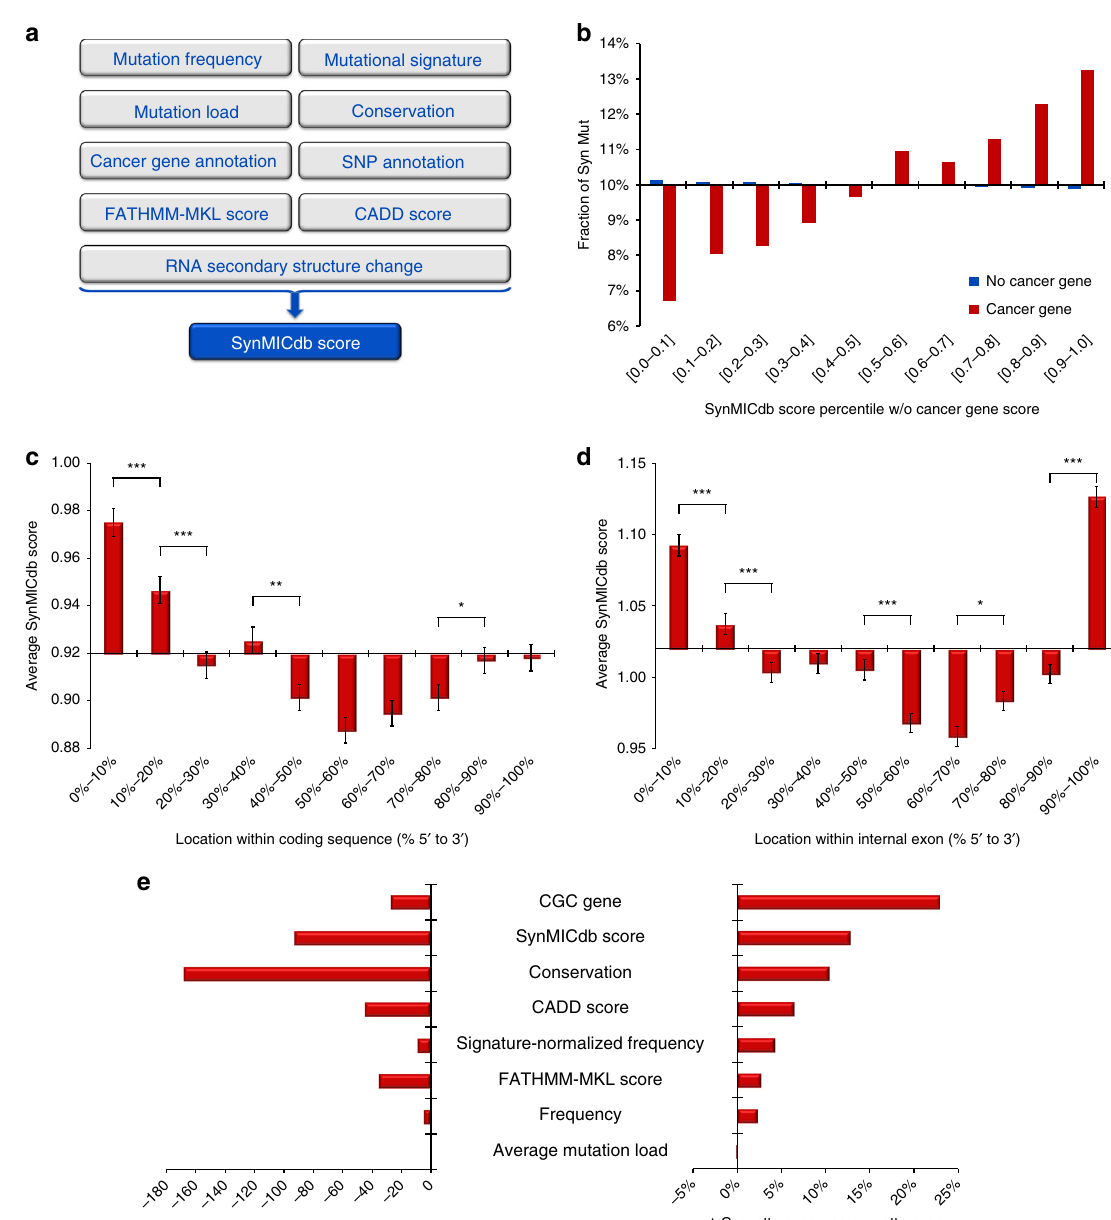
Fig. 3 The SynMICdb Score. a Nine parameters are integrated into the SynMICdb score for the estimated impact of a synonymous mutation. b Synonymous mutations in known cancer genes rank higher in the SynMICdb score than mutations in other genes. Depicted is the fraction of synonymous mutations in cancer genes (red) vs. no cancer genes (blue) in 10% bins of the SynMICdb score ranking (the cancer gene parameter was excluded from the score). A 10% frequency would indicate equal distribution along the 10 bins of the SynMICdb score ranks. Comparing the score rank averages between the group of non-cancer genes and cancer genes revealed a highly signi fi cant difference ( t -test, p < 0.001). c The average SynMICdb score is depicted along the length of the coding sequence in 10% bins. Signi fi cance: * p < 0.05, ** p < 0.01, ** p < 0.001 ( t -test). d The average SynMICdb score is depicted along the length of the internal exons in 10% bins. Signi fi cance: * p < 0.05, ** p < 0.001 ( t -test). b – d Bars represent the difference from the average ( x -axis) and the whiskers indicate the standard error (SEM). e The SynMICdb score, as well as multiple of its individual parameters are compared for 78,278 synonymous mutations falling into annotated cassette exons vs. all other synonymous mutations with the signi fi cance (log10 p -value t -test, left) and relative difference (% difference of average between both groups, right)